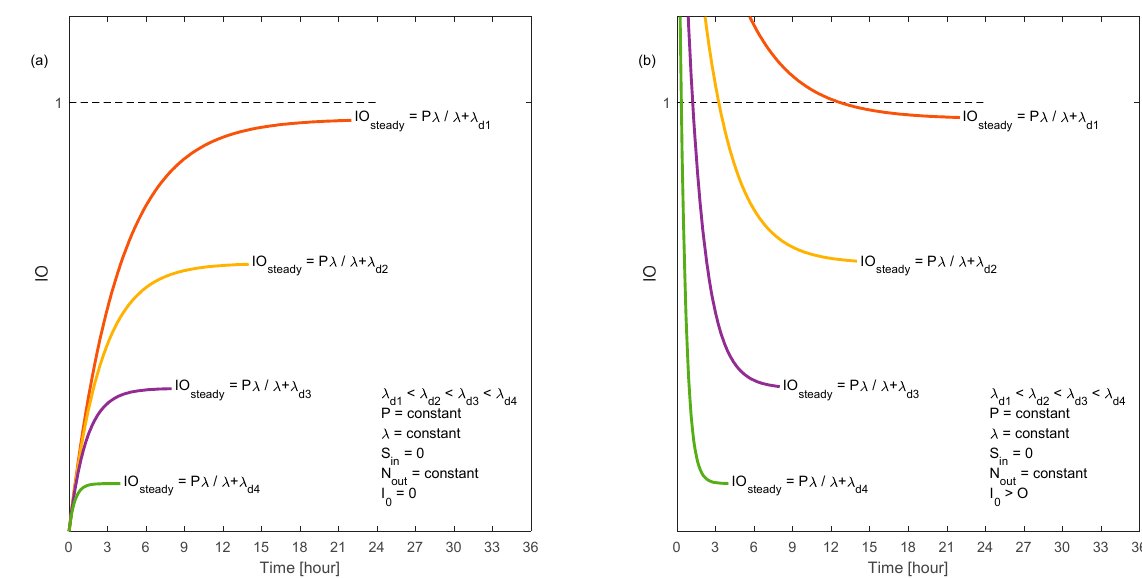
Figure A3. Role of the ventilation rate ( λ ) on the steady state indoor aerosol concentration (i.e., steady state indoor-to- outdoor concentration IO steady ) ( a ) when the initial indoor aerosol concentration I 0 = 0 and ( b ) when the initial indoor aerosol concentration is higher than that outdoors (i.e., I 0 > O). All other indoor aerosol parameters are held constant, as shown on the subplots.